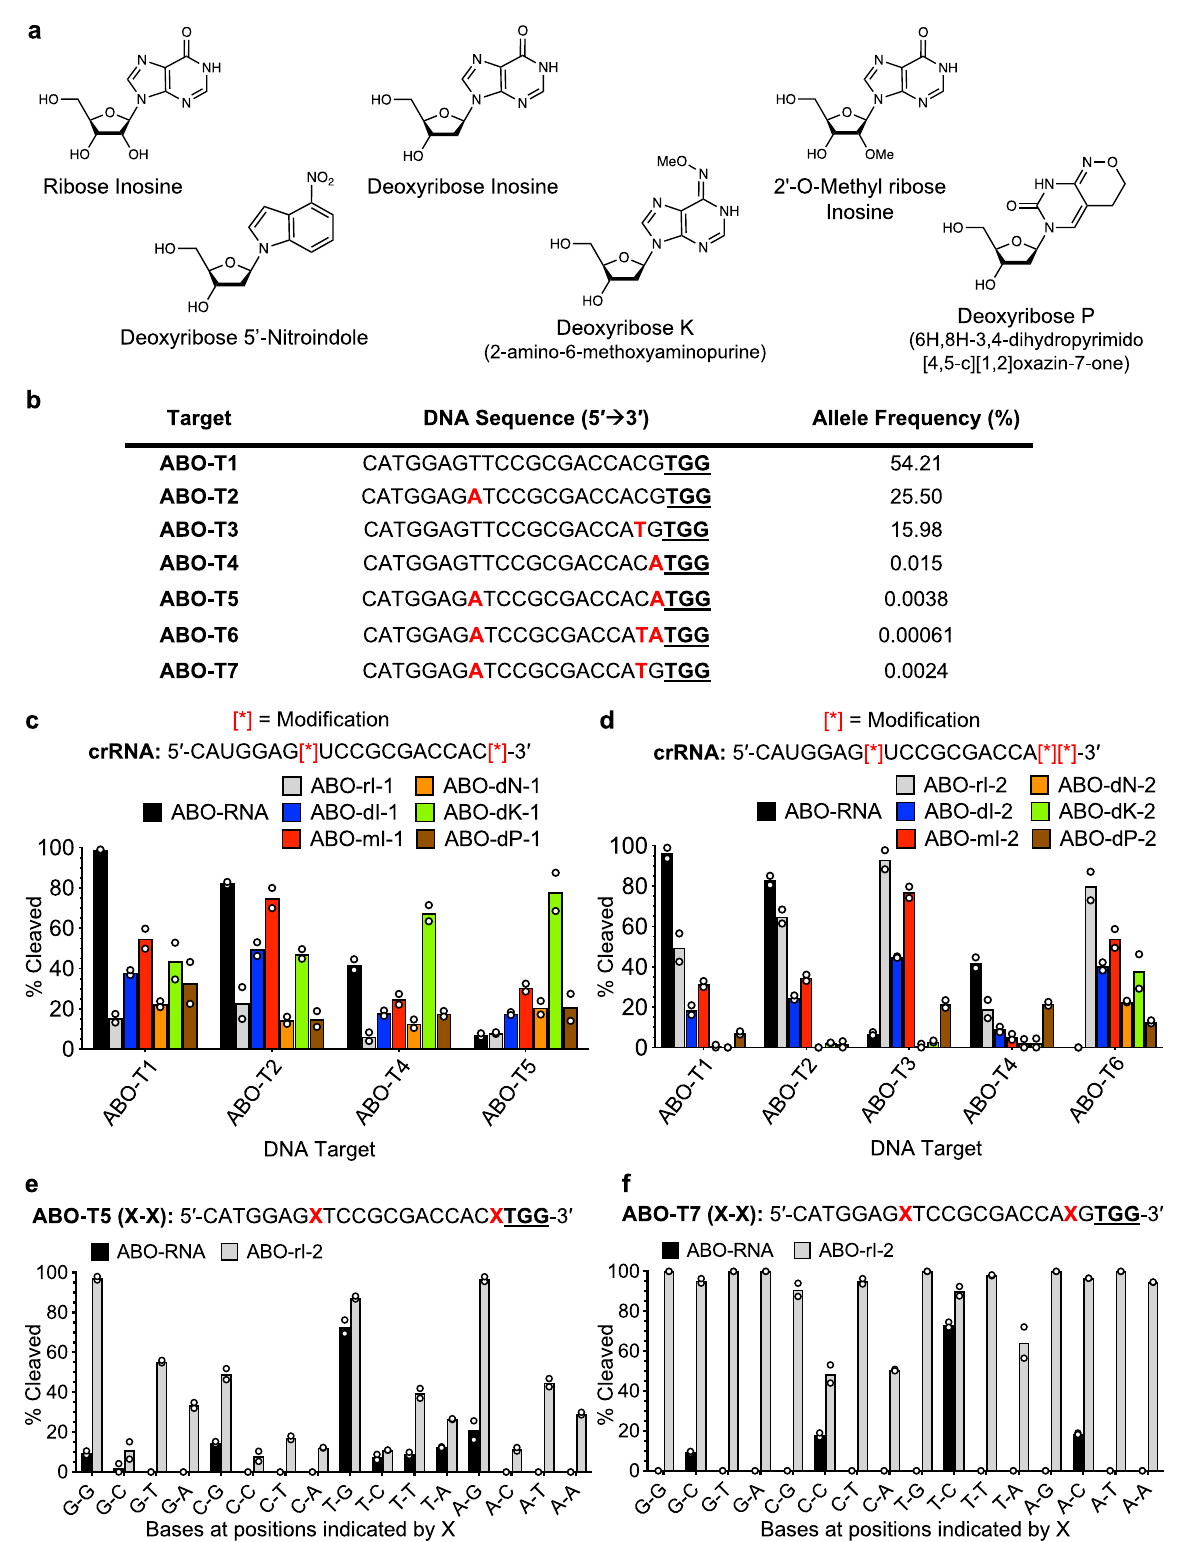
we tested the ability of Cas9 to cleave these sequences in vitro using an unmodi fi ed guide RNA (ABO-RNA) corresponding to the reference sequence (ABO-T1). Consistent with previous stu- dies on Cas9 speci fi city 11,44 , we observed robust cleavage of the on-target sequence (ABO-T1) and two sequences containing single SNPs (ABO-T2, ABO-T4), but weak or absent activity